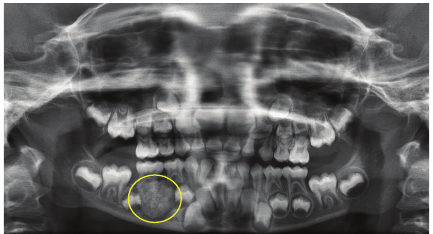
Figure 2: Preoperative panoramic radiograph with radiopacity surrounded by a radiolucent border associated with mesial root of lower right second primary